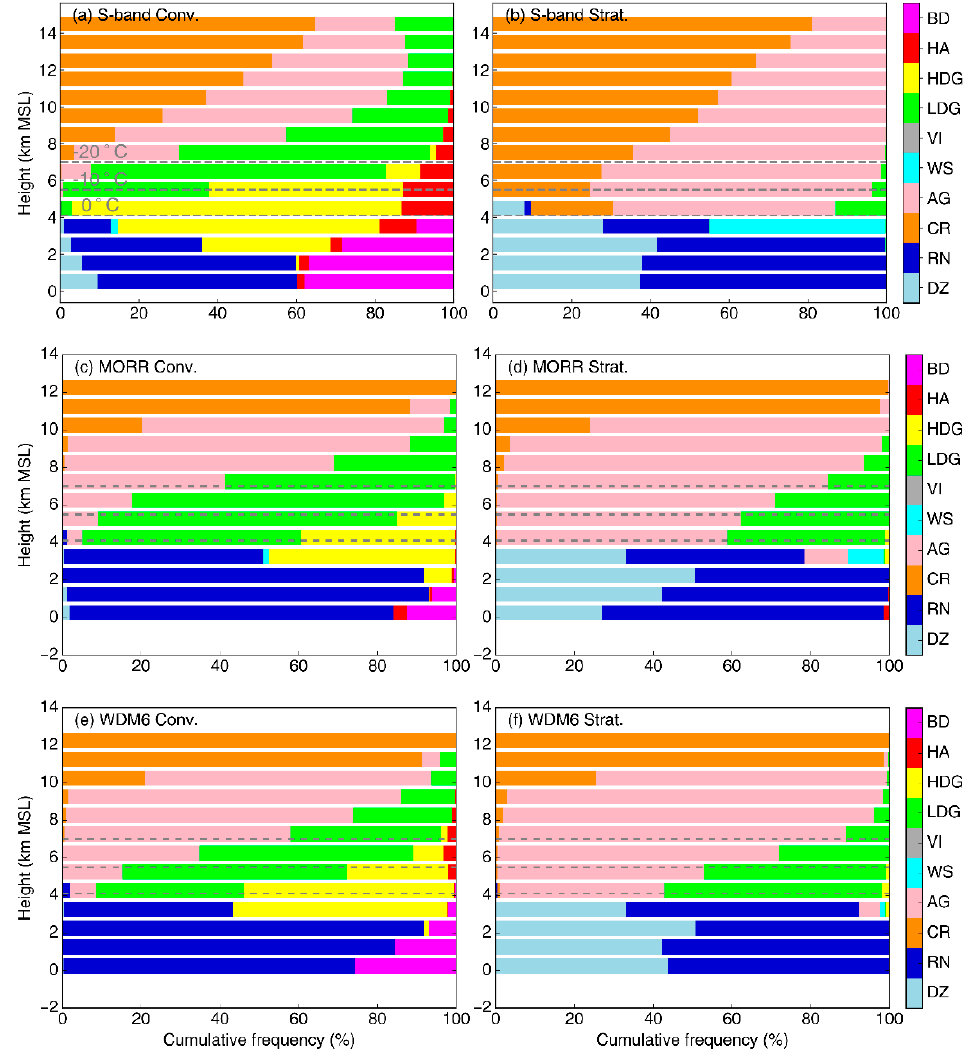
Figure 12. Hydrometeor identification frequency by height for convective (left) and stratiform (right) regions from ( a , b ) S-POL radar and the ( c , d ) MORR and ( e , f ) WDM6 microphysics schemes during 1200–1500 UTC. DZ = drizzle, RN = rain, CR = ice crystals, AG = aggregates, WS = wet snow, VI = vertical ice, LDG = low-density graupel, HDG = high-density graupel, HA = hail, BD = big drops/melting hail. The 0, − 10, and − 20 °C levels are indicated by gray dashed lines, as in Figure 11.